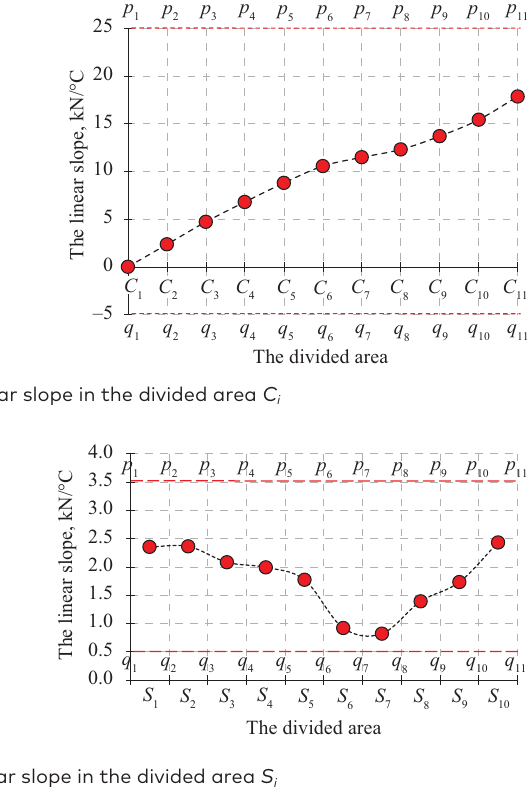
Figure 14. The linear slopes in different divided areas of splice plate